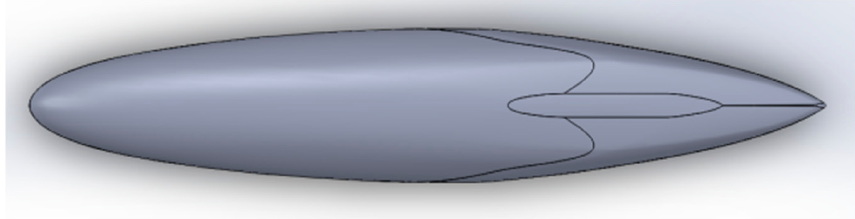
Figure 4. Car plan view corresponding to NACA 10 Airfoil.